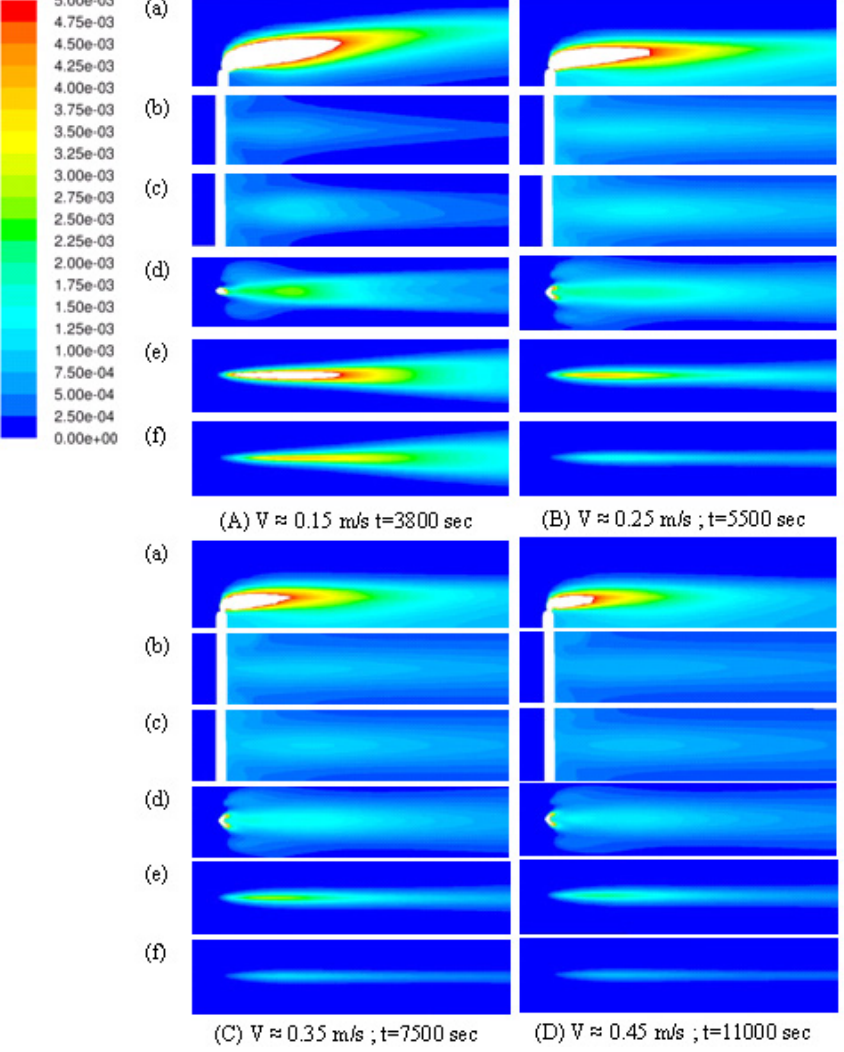
Fig. 11. Longitudinal views of pollutant concentration at four instants, for a periodic ambient current, BBL formulation, with blockage; (a) vertical cross section passing through the port center, (b–f) top view at different distances above the seabed: (b) 0m; (c) 0.5m; (d) 1.2m; (e) 2.5m; (f)